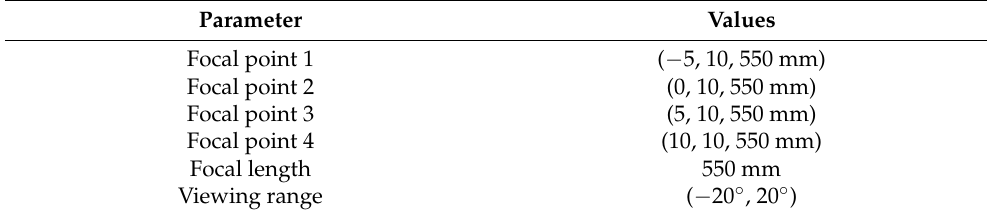
Table 1. The detailed design parameters of the HOE.